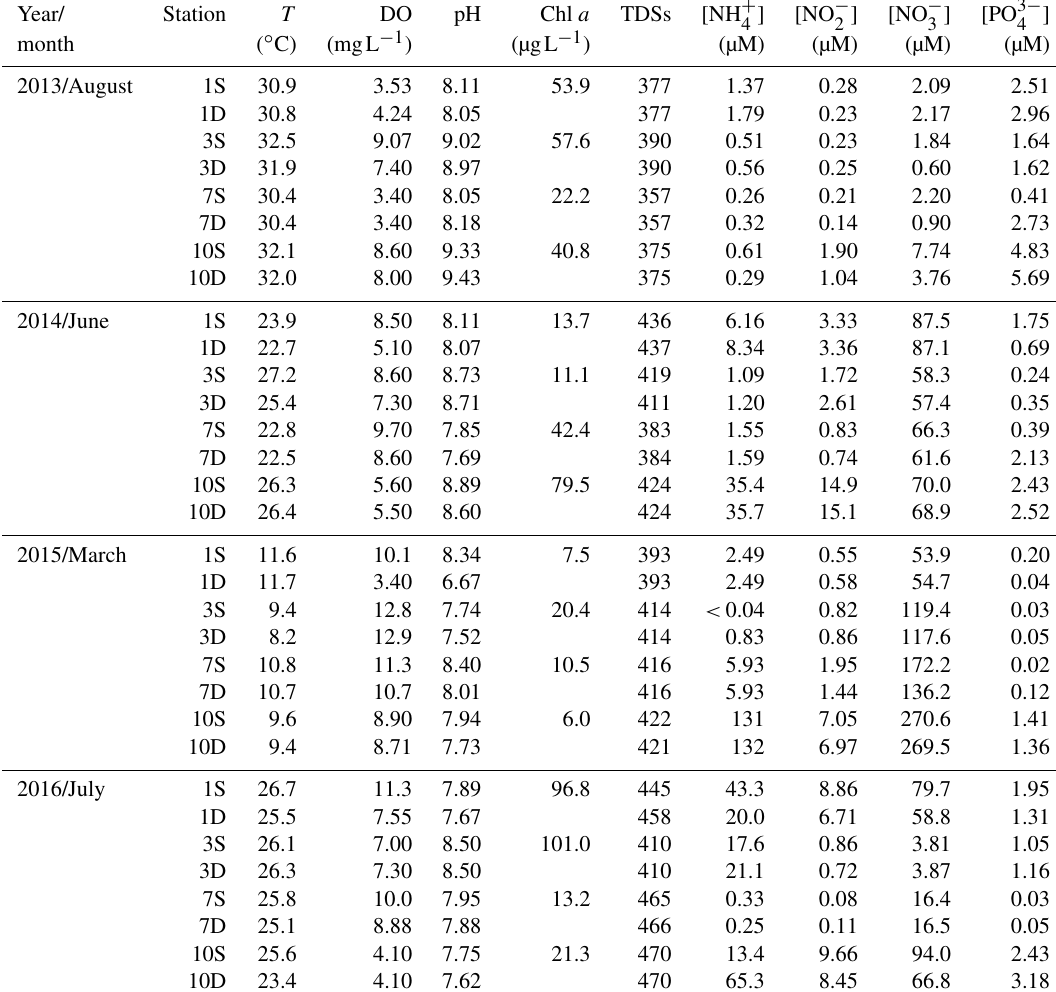
Table 1. Environmental characteristics during sampling events for each station and depth: temperature ( T ), dissolved oxygen (DO), pH, chlorophyll a (chl a ; surface only), total dissolved solids (TDSs), and in situ nutrient concentrations. S in station name stands for surface water (0.2m), and D stands for deep, near-bottom water ( ∼